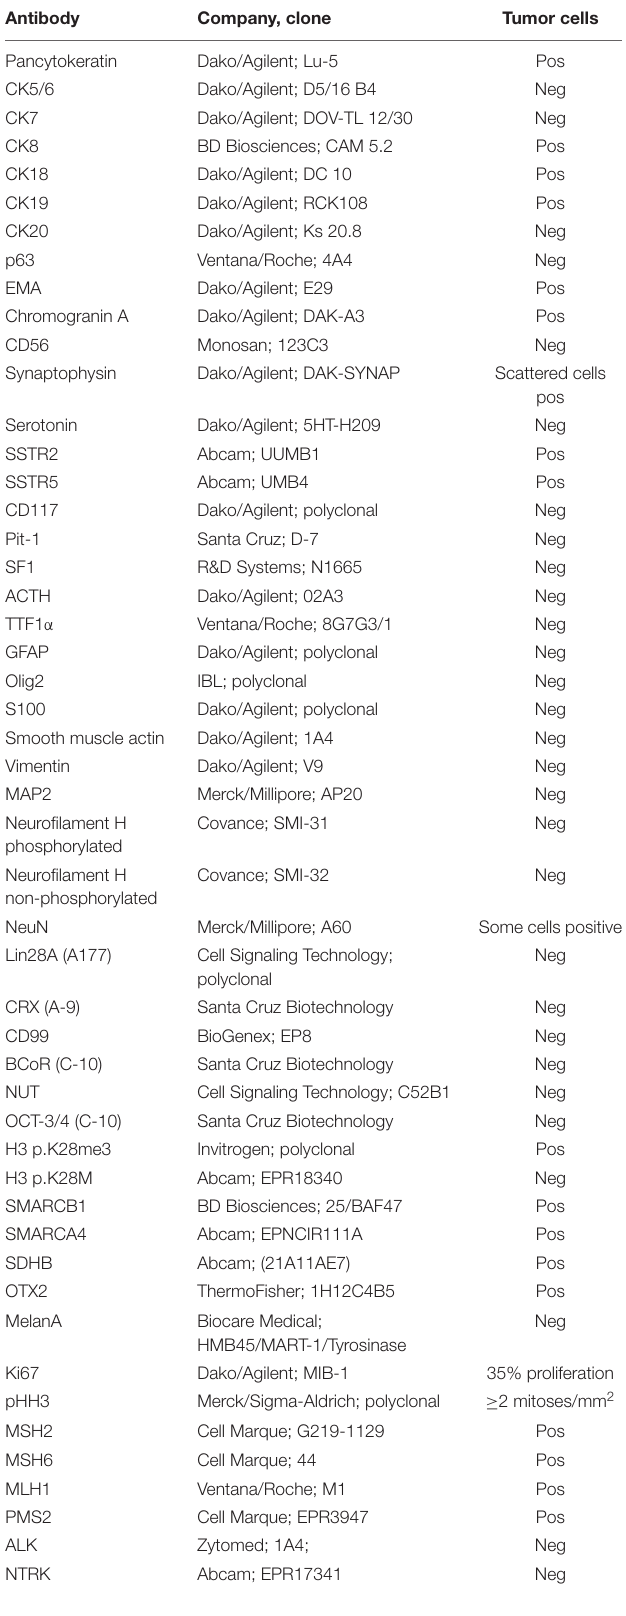
TABLE 1 | All antibodies/company used and the respective results in the tumor cells. Antibody Company, clone Tumor cells